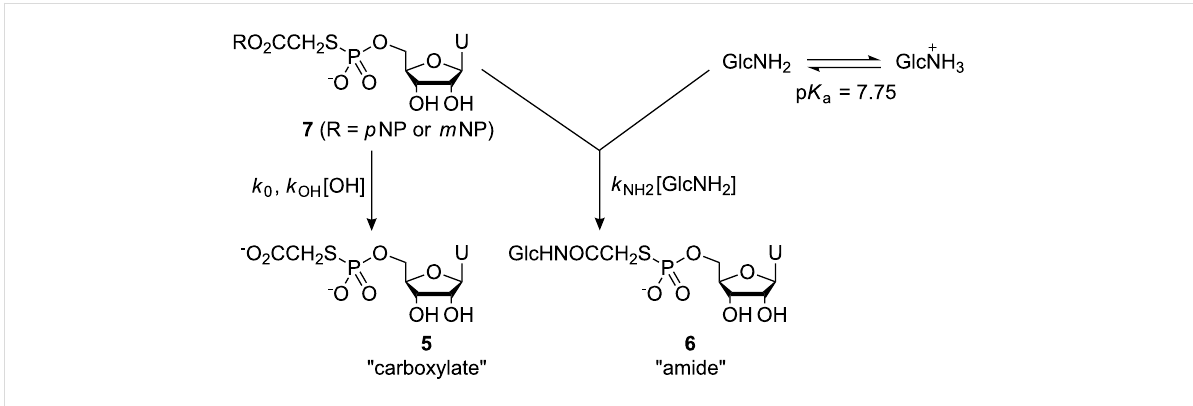
Scheme 5: Kinetic model for competing hydrolysis and aminolysis processes of nitrophenyl esters 7 (R = p NP) and 7 (R = m NP) in the presence of D-glucosamine.